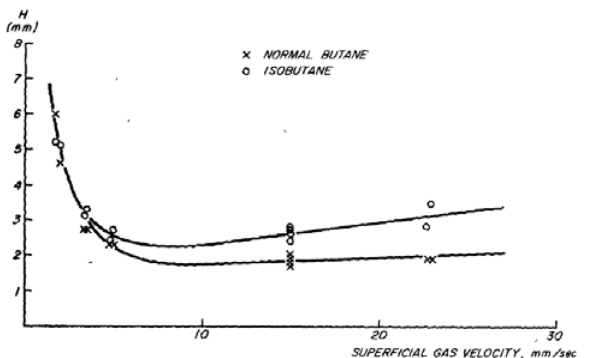
Figure 5. Plate height, H , in dependence on the mobile phase velocity, taken from the original publication of van Deemter, Zuiderweg and Klinkenberg from 1956. Measurements were carried out with a packed bed column under isothermal conditions. For details see Supplementary Information and ref. [43] . From ref. [43] with